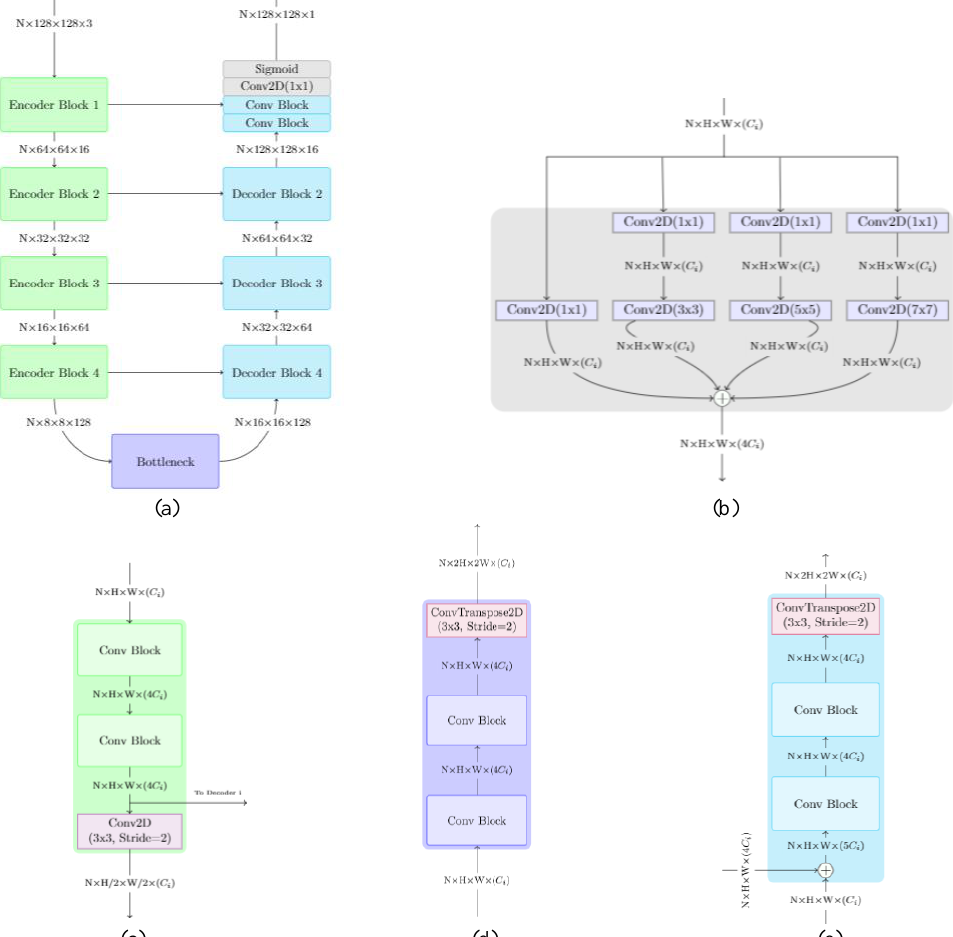
Figure 1. UNET Architecture, (a) full architecture and (b) encoder, (c) decoder, (d) bottleneck, and (e) conv blocks. The ⊕ operator represents the channel concatenation